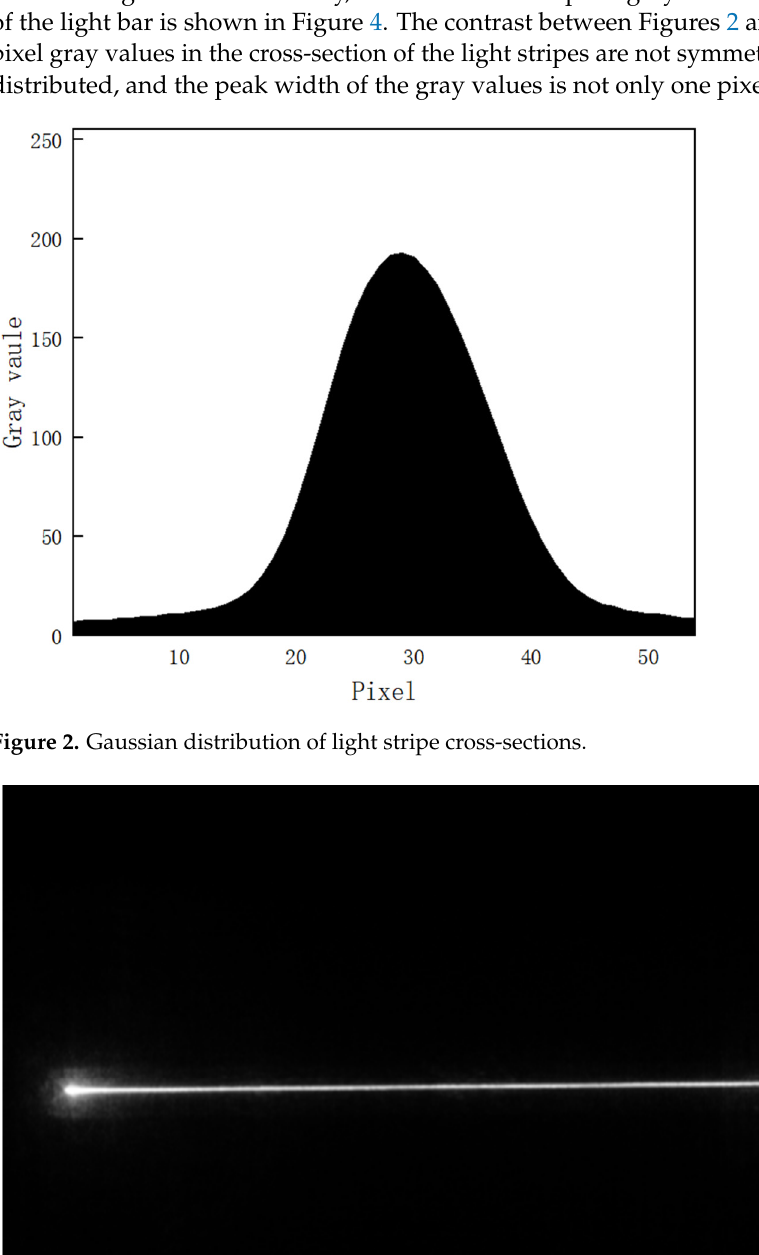
Figure 1. Algorithm flow chart.